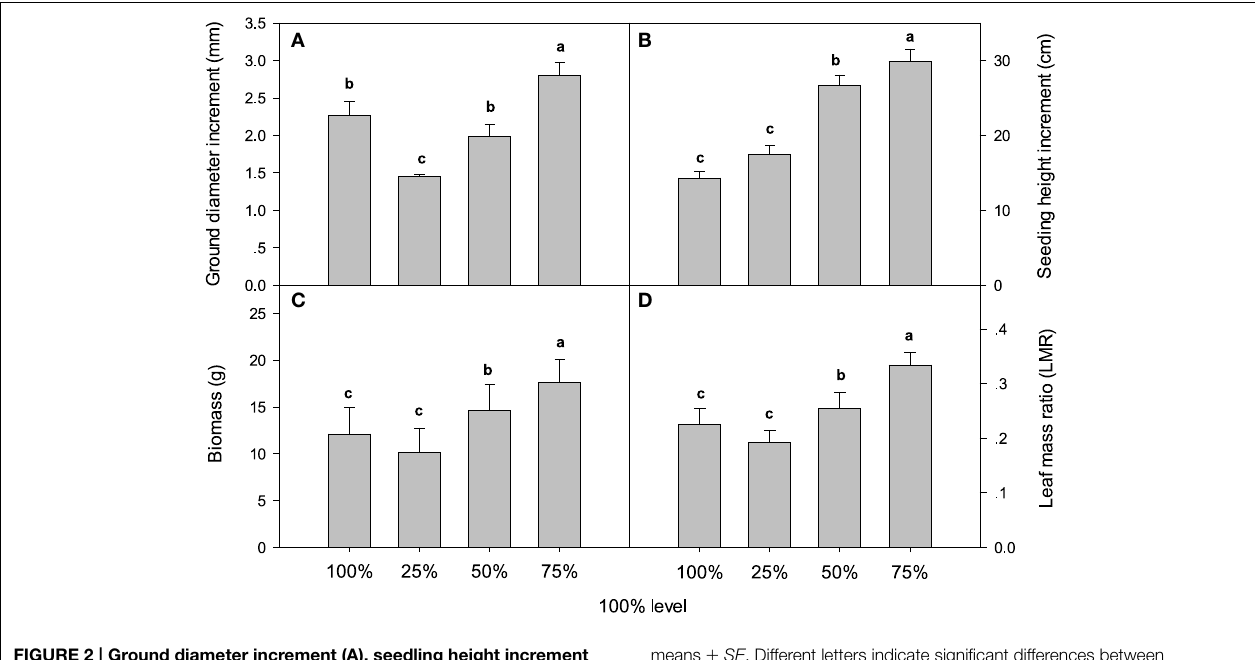
means ± SE . Different letters indicate significant differences between irradiance treatments ( P < 0 . 05 ); n = 5 . 100% level = 1500 ± 30 µ mol m − 2 s − 1